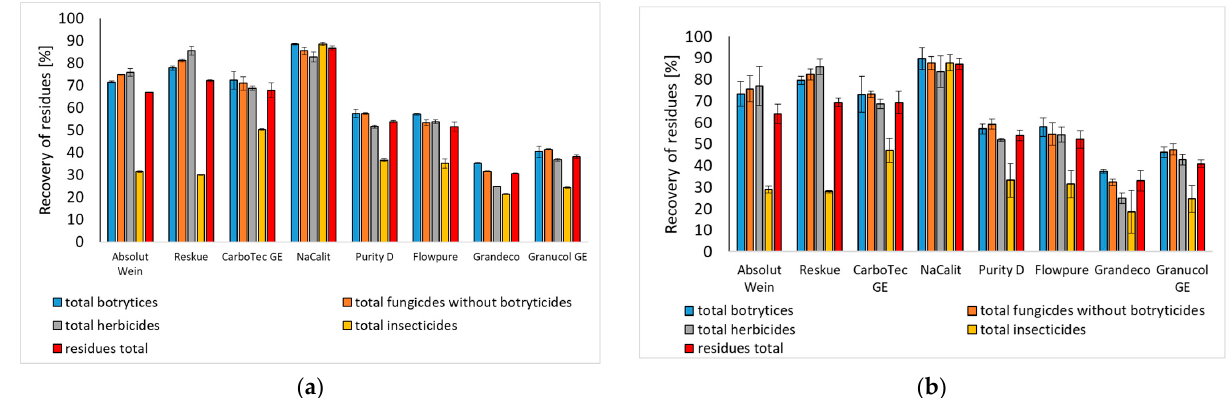
Figure 3. Recovery of pesticide residues after fining; ( a ) white wine; ( b ) red wine. The greatest reduction was found in the total insecticides studied, where more than 50% of the insecticide content was reduced (recovery less than 50%) in all products except bentonite. The reduction of botryticides, fungicides (excluding botryticides) and one herb- icide were about the same. In the case of the fining preparations based on yeast cell wall preparations, the reduction tended to be greater for the botryticides compared to the other residues, while in the case of the other fining products, the herbicide studied was reduced more. The reduction for the carbon products was between 50 and 80% (recovery 50–20%), that for the plant fiber between 40–60% (recovery 60–40%), and that for the two mixed products Purity D and CarboTec GE between 30–60% (recovery 70–40%). Purity D per- formed better, the two fining agents based on yeast wall products led to a reduction be- tween 15–60% (recovery 85–40%) and bentonite between 10–15% (recovery 90–85%). A similar result was obtained for red wine (Figure 4). The charcoal products reduced the pesticide residues most effectively, followed by the plant fiber Flowpure, the mixed prod- ucts and the yeast wall products. The reduction was lowest for NaCalit. The insecticides studied were reduced more than the other groups. 3.6. Influence of Applied Wine Fining on Targeted Volatile Compounds of Wine Volatile profiles of the experimental wines were determined. Free monoterpenes, higher alcohols, C6 alcohols and ester compounds were analyzed. The results of the indi- vidual compounds can be found in the Supplementary Data: Table S5 for white wine and Table S6 for red wine. Table 8 summarizes the individual volatile compounds in sum pa- rameters. Figures 4 and 5 show the recoveries of the respective groups of volatile com- pounds for white wine and red wine. Table 8. Concentration of volatile sum parameters before and after treatment with different fining agents. Residues